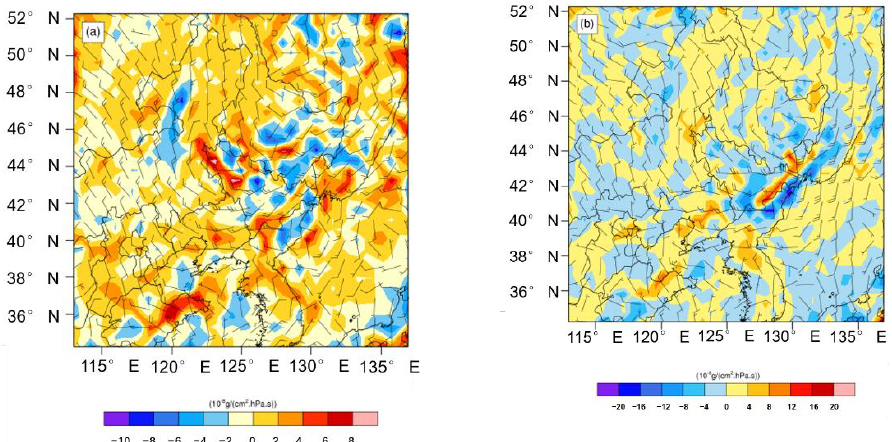
Figure 7. Horizontal winds (barbs; m · s − 1 ) and water vapor flux divergence (shaded; 10 − 8 g/(cm 2 · hPa · s)) at ( a ) 12:00 LST and ( b ) 17:00 LST at 850 hPa in Domain 2 on 3 July 2019. A full bar is 4 m · s − 1 .